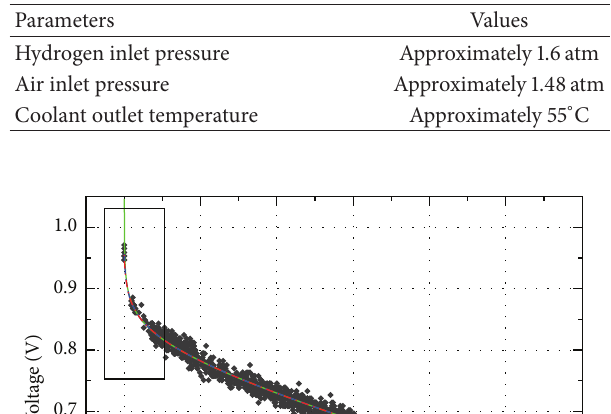
Table 5: Operational conditions of the fuel cell stack (road test).